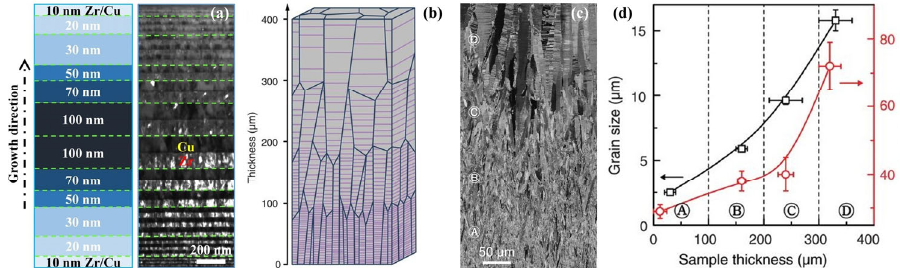
Figure 10. ( a ) Schematic and TEM image of the gradient ‐ nanolayered Cu/Zr metal [162]; ( b ) sche ‐ matics and SEM observation ( c ) of GNT Cu composed of homogeneous NT components Ⓐ , Ⓑ , Ⓒ and Ⓓ [28]; ( d ) distribution of grain size and twin thickness along the sample thickness (the direc ‐ tions of the arrows represent the corresponding vertical axis, respectively) [28].